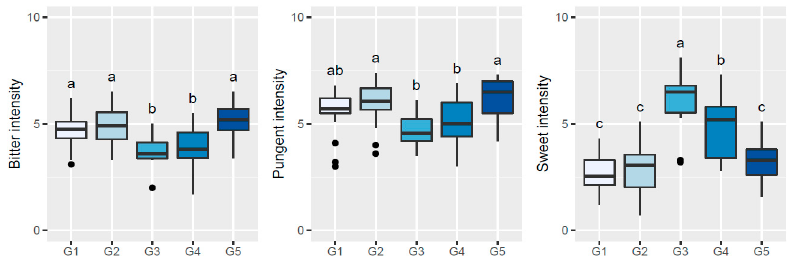
Figure 3. Sensory profile boxplots (bitter, pungent, and sweet intensity) found in olive oils extracted from olives from centenarian olive trees in the Côa Valley region. Different lowercase letters signify statistically significant differences at a significance level of 5% (one-way ANOVA followed by Tukey’s multi-comparison test).